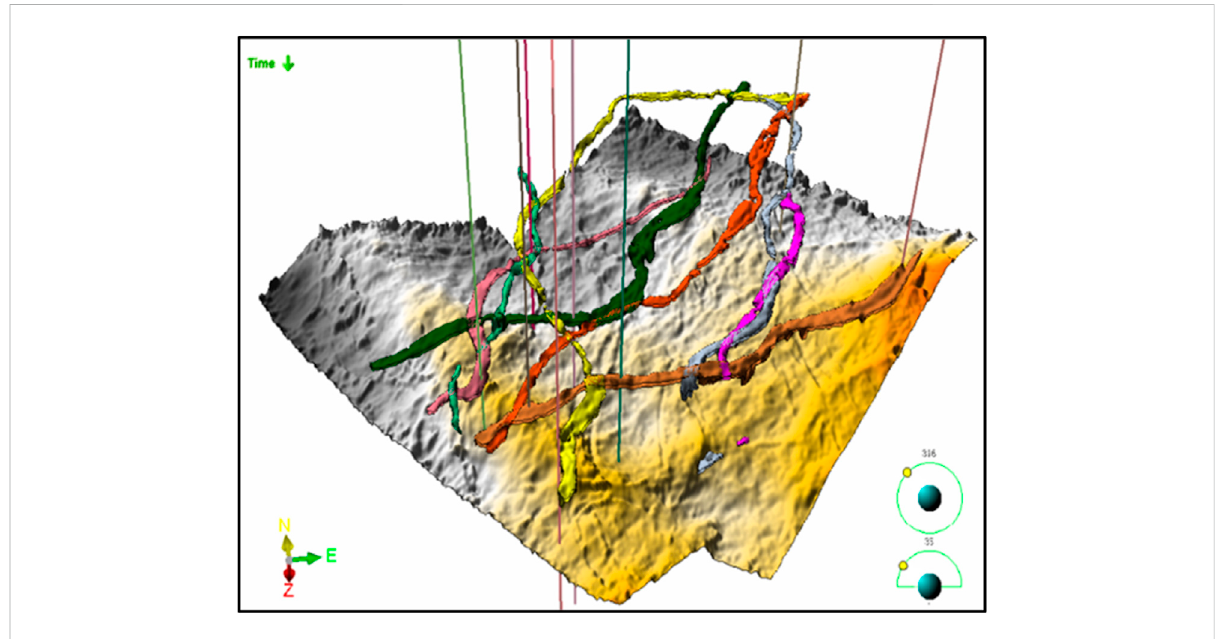
FIGURE 1 3D characterization of Shaximiao formation channel in Jinqiu gas fi